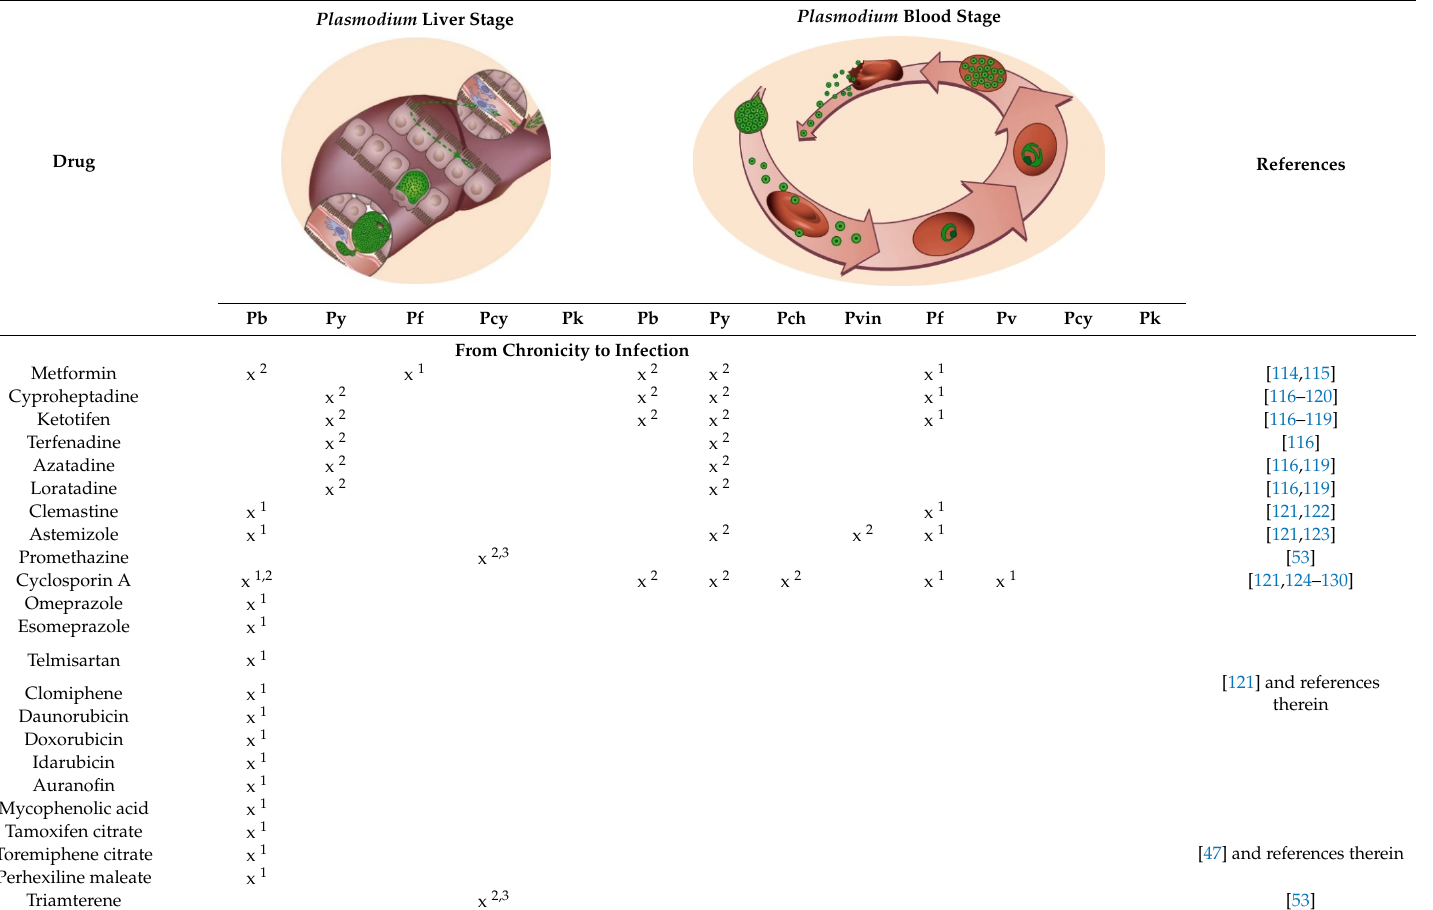
Table 1. Cont . Table 1. Summary of drugs that have been tested against the liver and/or blood stages of Plasmodium infection.